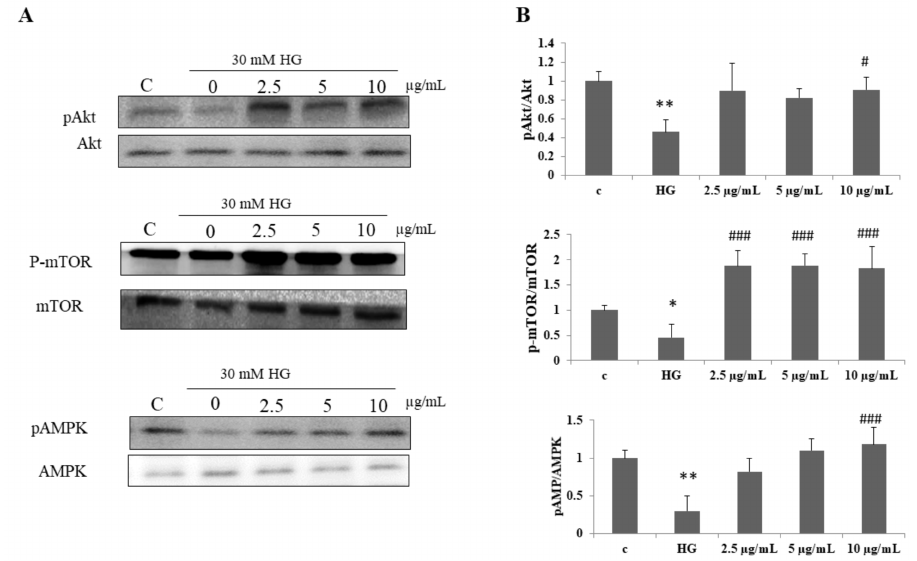
Figure 5. Effect of DI-10 on Akt, mTOR, and AMPK phosphorylation under hyperglycemic conditions in C2C12 cells. ( A ) Immuno blot showing phosphorylation of Akt, mTOR, and AMPK proteins involved in protein synthesis. ( B ) Graph showing densitometric analysis. ** p < 0.01 and * p < 0.05 compared to control group and # p < 0.05 and ### p < 0.001 compared to the high glucose. 3.6. DI-10 Inhibits Muscle Atrophy under Hyperglycemic Conditions through Modulating MAFbx and MuRF1